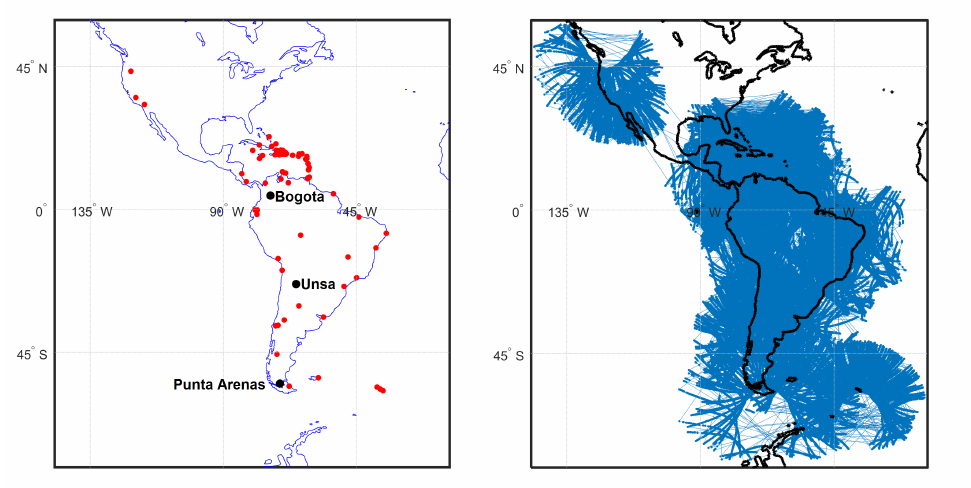
Figure 2. An overview of the GNSS network and observations used in this study, where the left plot indicates the distribution of 62 GNSS reference stations, and the right plot shows the distribution of ionospheric observations (blue dots). Three stations are shown by black dots on the left plot, which correspond to Bogota (lat = 4.64007 and lon = 285.91906 in Columbia), Unsa (lat = − 24.72746 and lon = 294.59236 in Argentina), and Punta Arenas (lat = − 53.13695 and lon = 289.12011 in